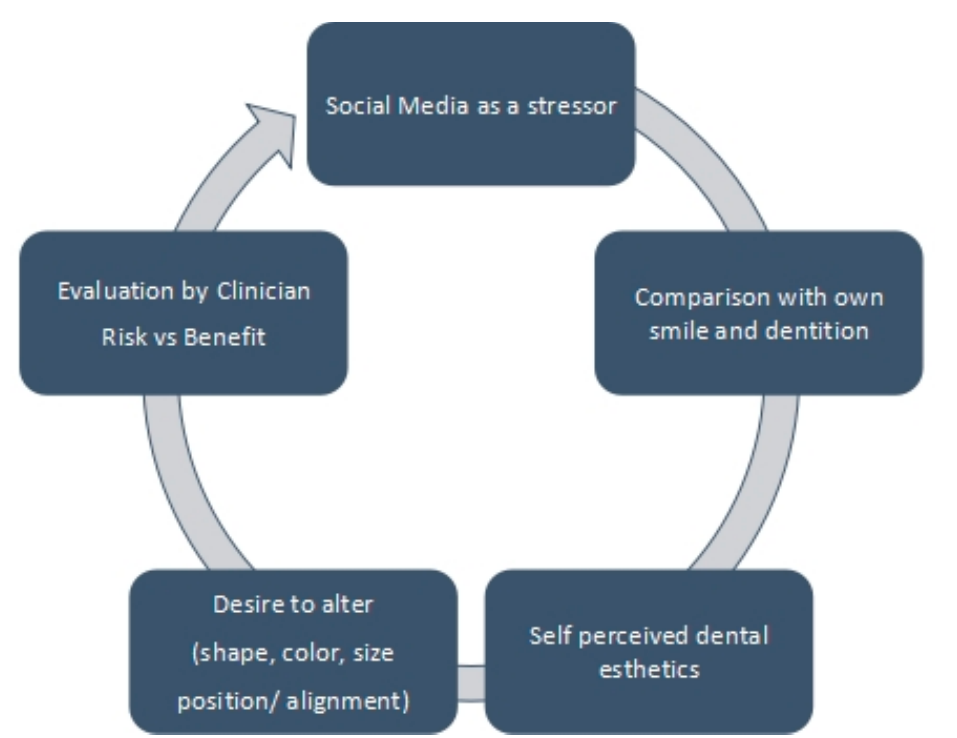
Figure 1. The impact of social media on dental aesthetic alteration.